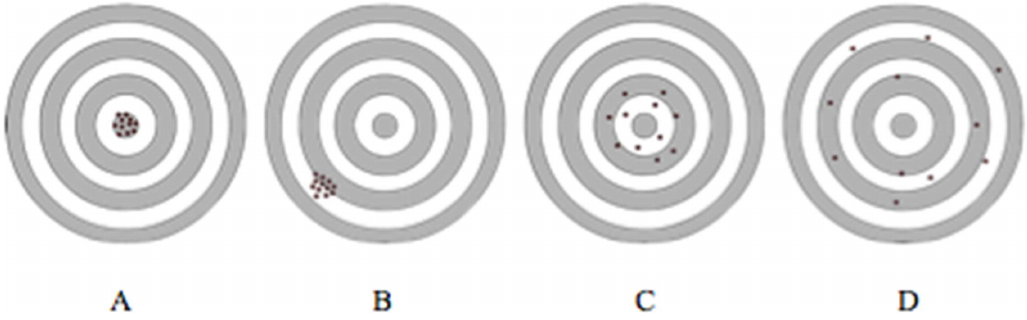
Fig 4. Formulation of accuracyand precision. A: high accuracy, high precision, B: high accuracy, low precision, C: low accuracy, high precision,D: low accuracy, low precision.